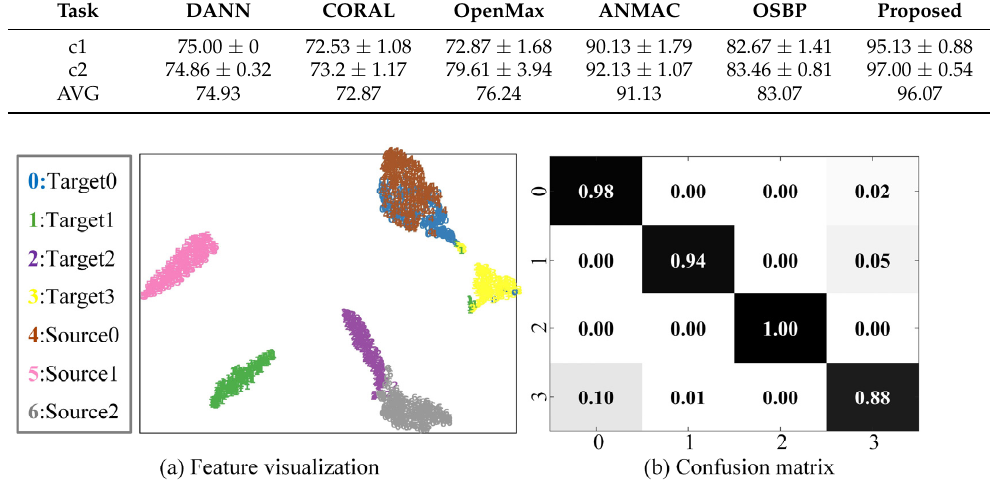
Table 7. Diagnosis results in the centrifugal pump dataset (accuracy (%) ± standard deviation).